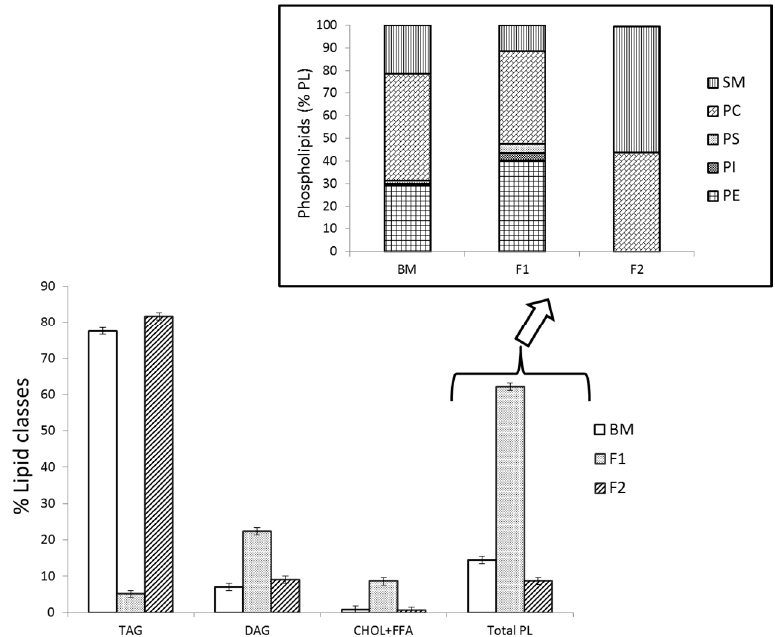
Figure 1. Lipid classes composition of buttermilk (BM) and isolated fractions F1 and F2 (in % of total fat) and phospholipid content (% of PL) determined by HPLC-ELSD. TAG triacylglycerols; DAG, diacylglycerols; CHOL + FFA, cholesterol + free fatty acids; MAG, monoacylglycerols; PL, polar lipids; PE, phosphatidylethanolamine; PI, phosphatidylinositol; PS, phosphatidylserine; PC, phosphatidylcholine; SM, sphingomyelin.